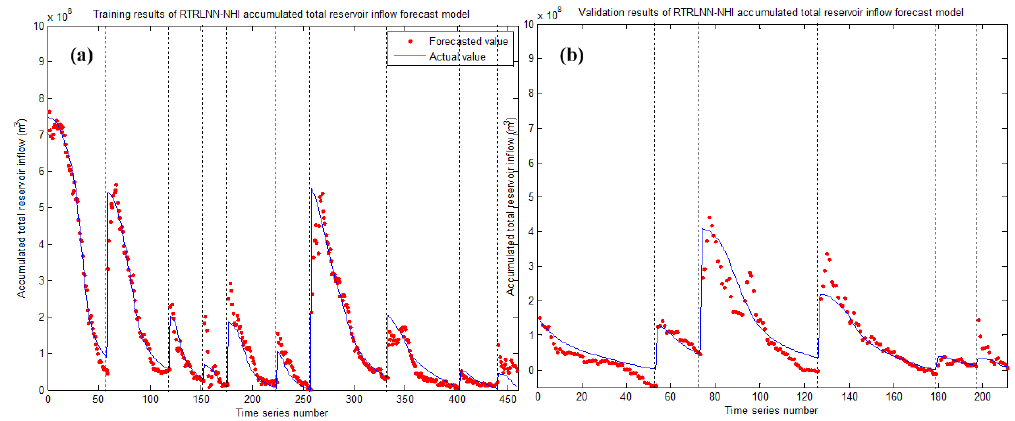
Figure 12. Training and validation results of RTRLNN-NHI-based accumulated total reservoir inflow forecast model: ( a ) training stage; ( b ) validation